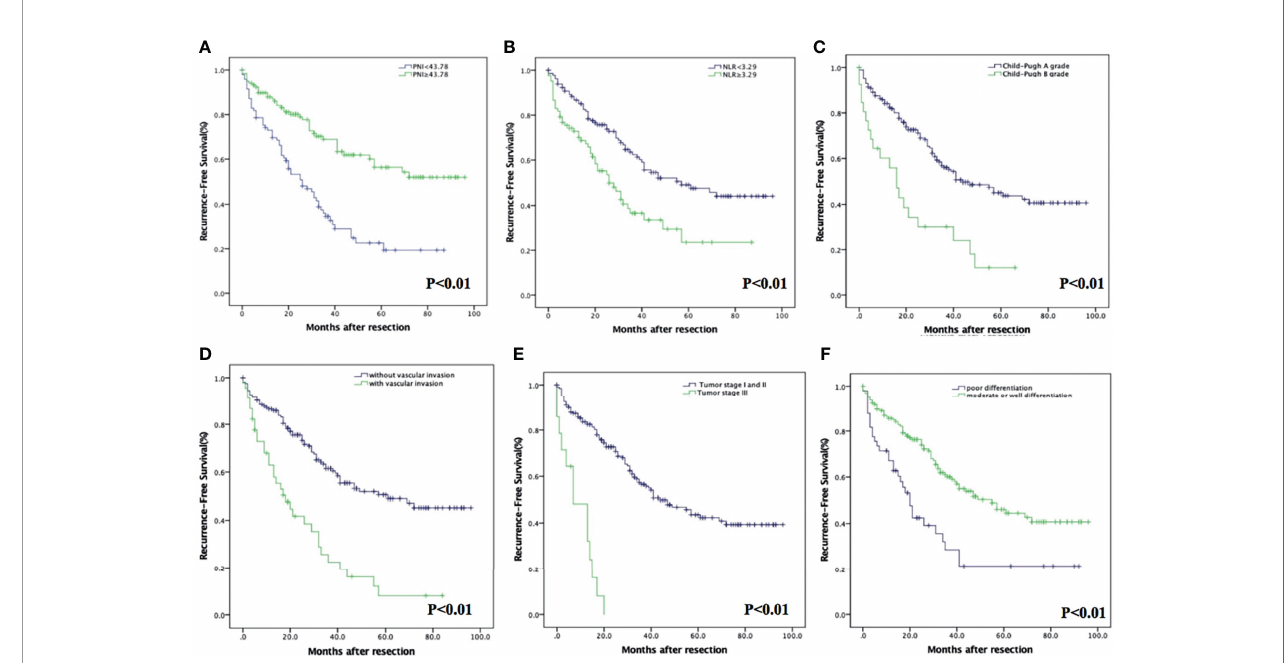
FIGURE 3 | Kaplan – Meier analysis of HCC patients showing RFS curves strati fi ed according to PNI (A) , NLR (B) , Child – Pugh grade (C) , vascular invasion (D) , tumor stage (E) , and degree of differentiation (F) .